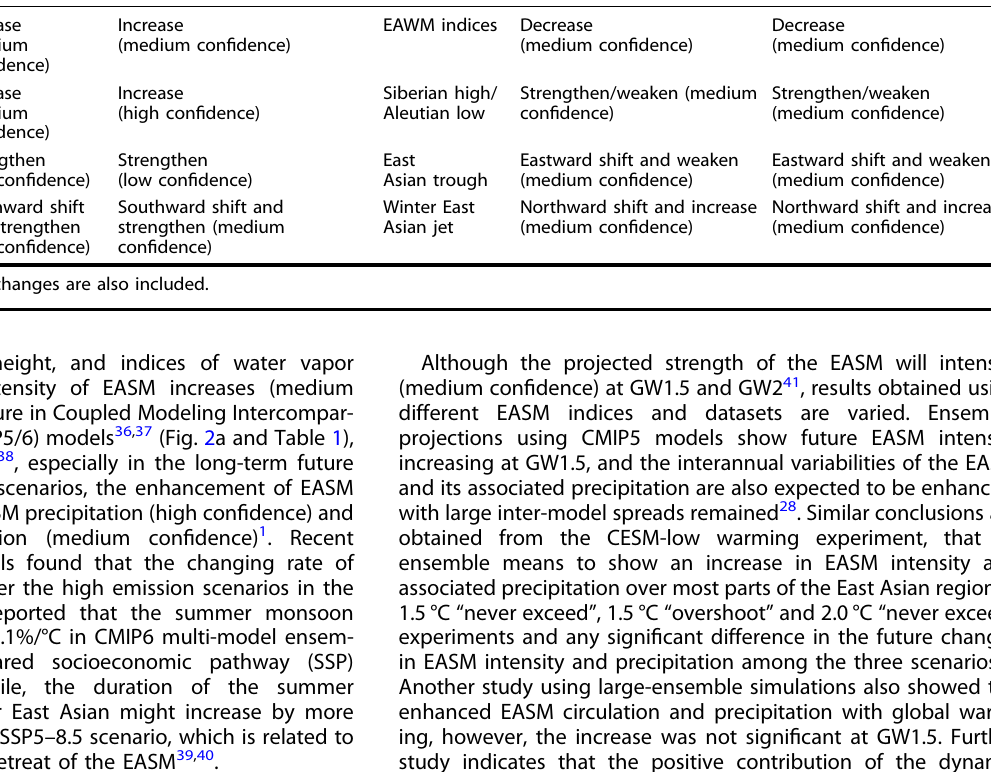
Winter East Northward shift and increase Asian jet (medium con fi dence)